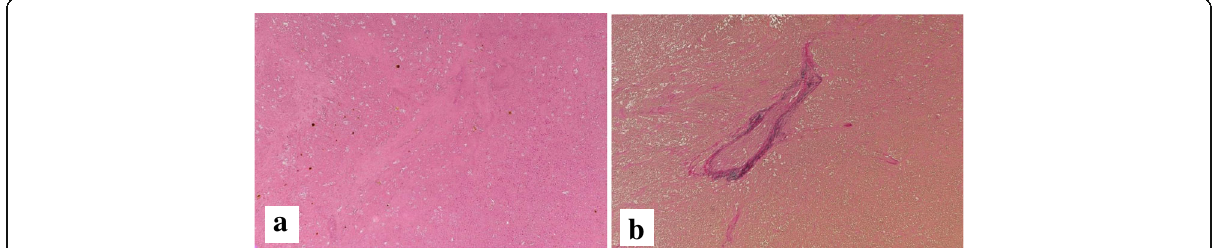
Fig. 5 Hematoxylin and eosin staining (× 40 magnification) showed massive coagulation in the central part of the tumor ( a ). Verhoeff-Van